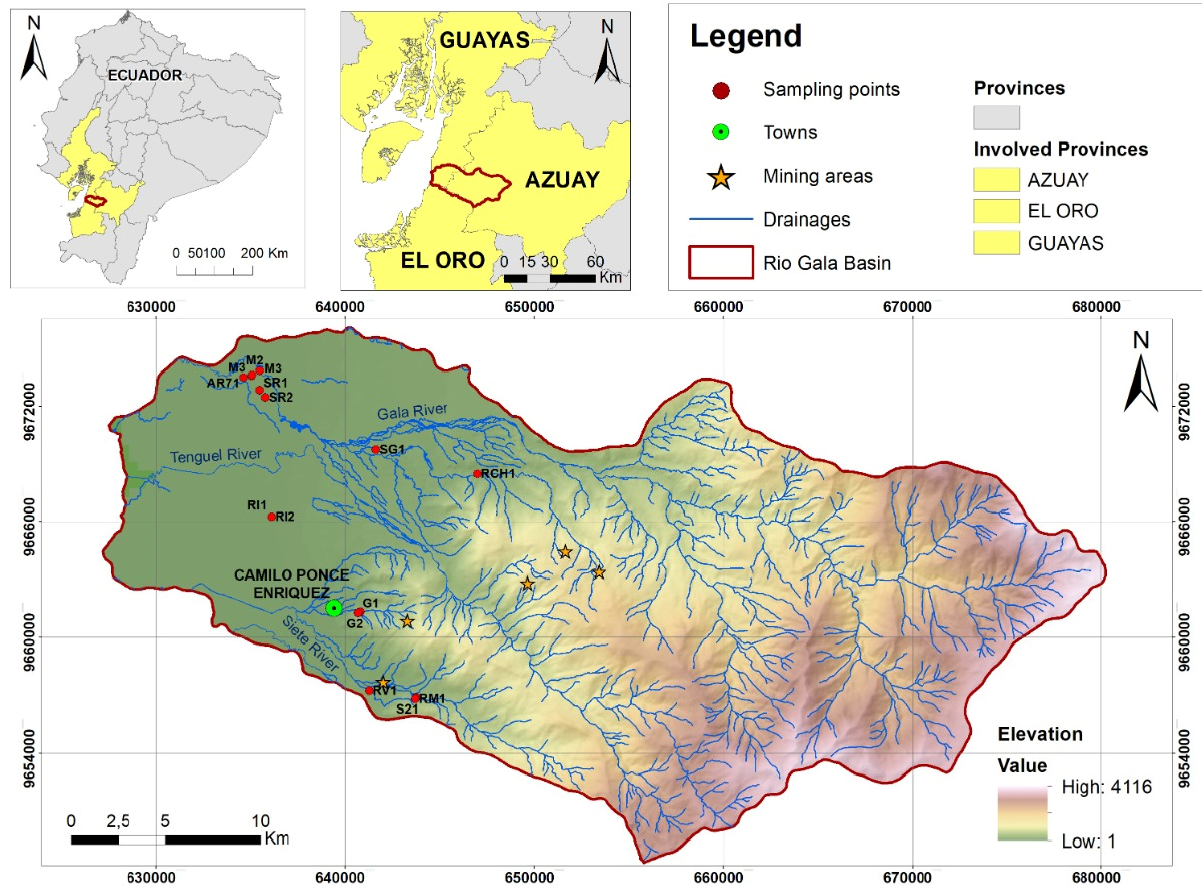
Figure 1. Macro location of sampling points. Mines near the sampling site. Sampling sites .